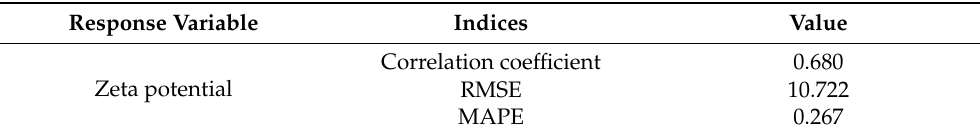
Figure 2. Actual and predicted zeta potentials from MLR. Table 2. MLR model performance